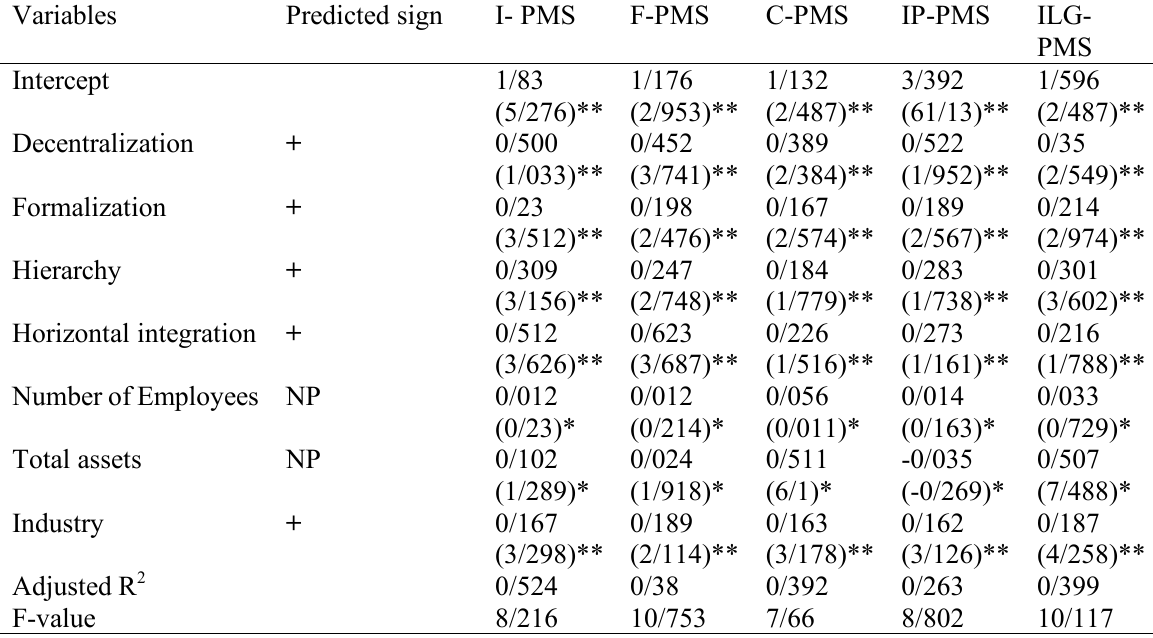
Table 9 . The impact of organizational structure dimensions on performance measurement